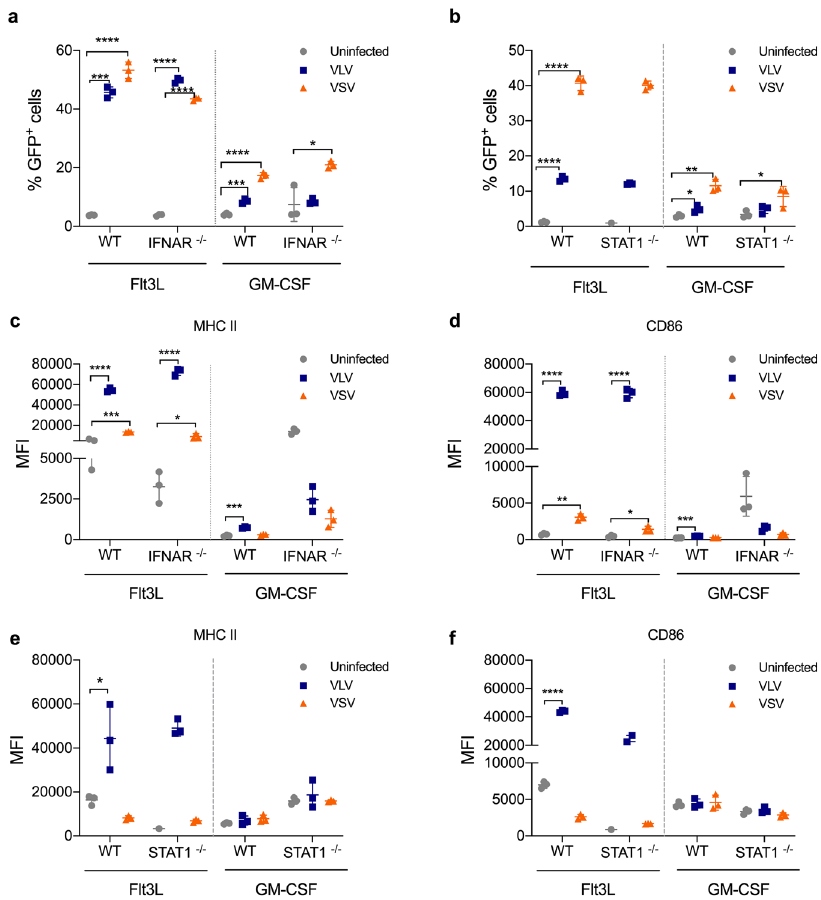
Fig. 5 Flt3L DC infection and activation is independent of the type I IFN response. a , b BMDCs were generated from WT, IFNAR − / − , and STAT1 − / − mice, and then infected with VLV or VSV for 18 h (MOI 10). GFP expression in Flt3L and GM-CSF BMDCs from a IFNAR-de fi cient or b STAT1-de fi cient mice. c , d Expression of c MHC II and d CD86 on IFNAR − / − -derived Flt3L BMDCs after VLV or VSV infection. e , f Expression of e MHC II and f CD86 activation markers after infection of STAT1 − / − Flt3L BMDCs. Data are expressed as mean ± standard deviation. * p < 0.05, ** p < 0.01, *** p < 0.001, **** p < 0.0001 compared to uninfected control by one- or two-way